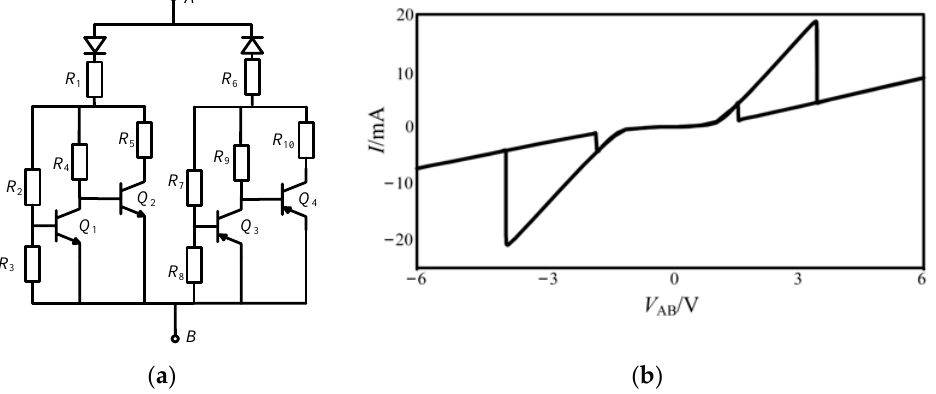
Figure 3. Bidirectional NDR hysteresis unit and its i - v characteristic curve: ( a ) bidirectional NDR hysteresis unit, ( b ) the i - v characteristic curve of bidirectional NDR hysteresis unit.